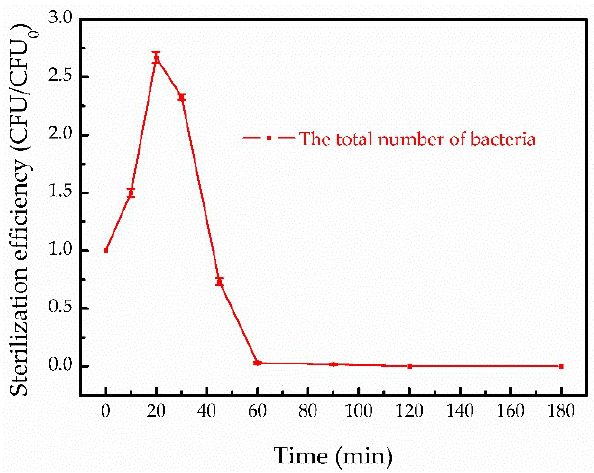
Figure 8. Fenton-like system for disinfection of filtered water.